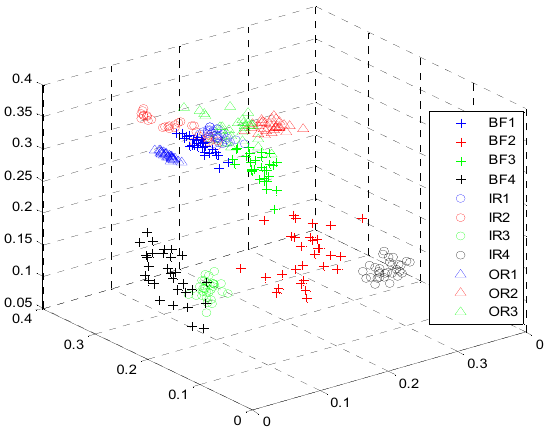
Figure 9. Wavelet packet energy entropy clustering diagram under different fault conditions for a load of 2 hp.